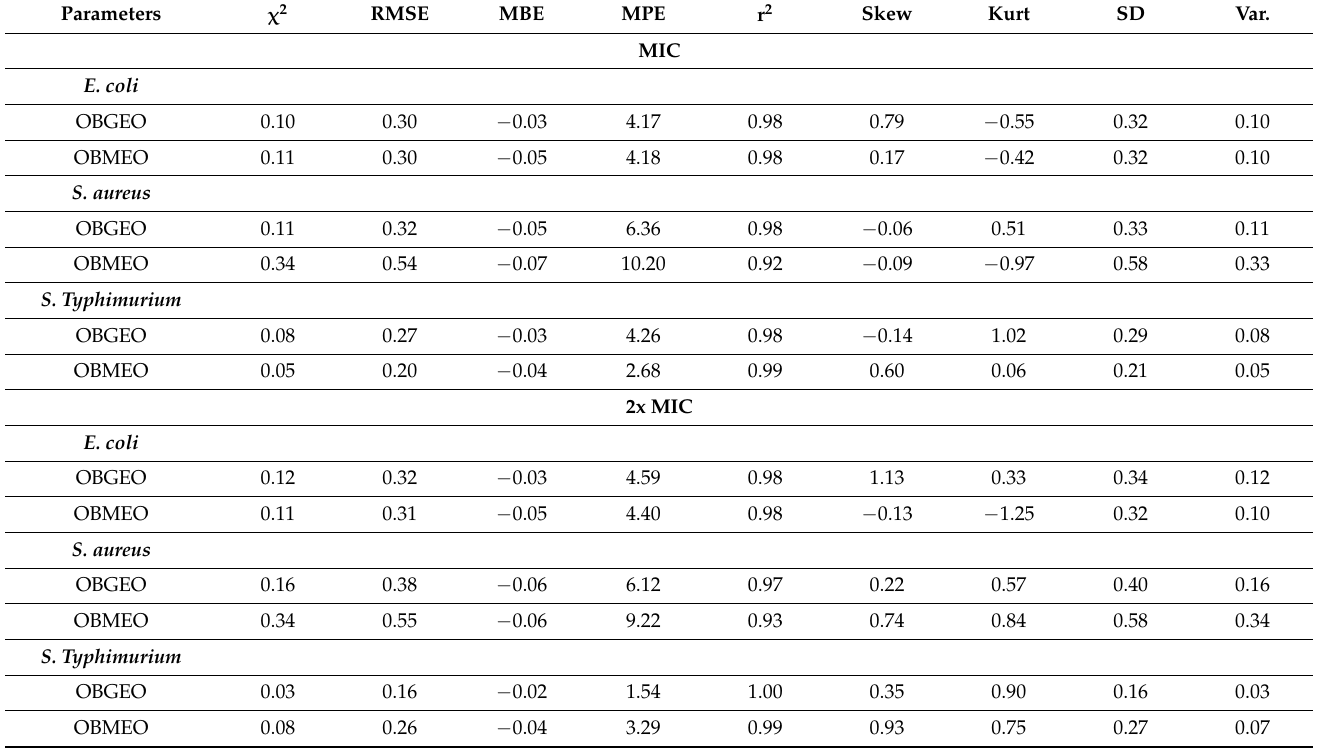
Table 6. The ‘goodness of fit’ tests for prediction